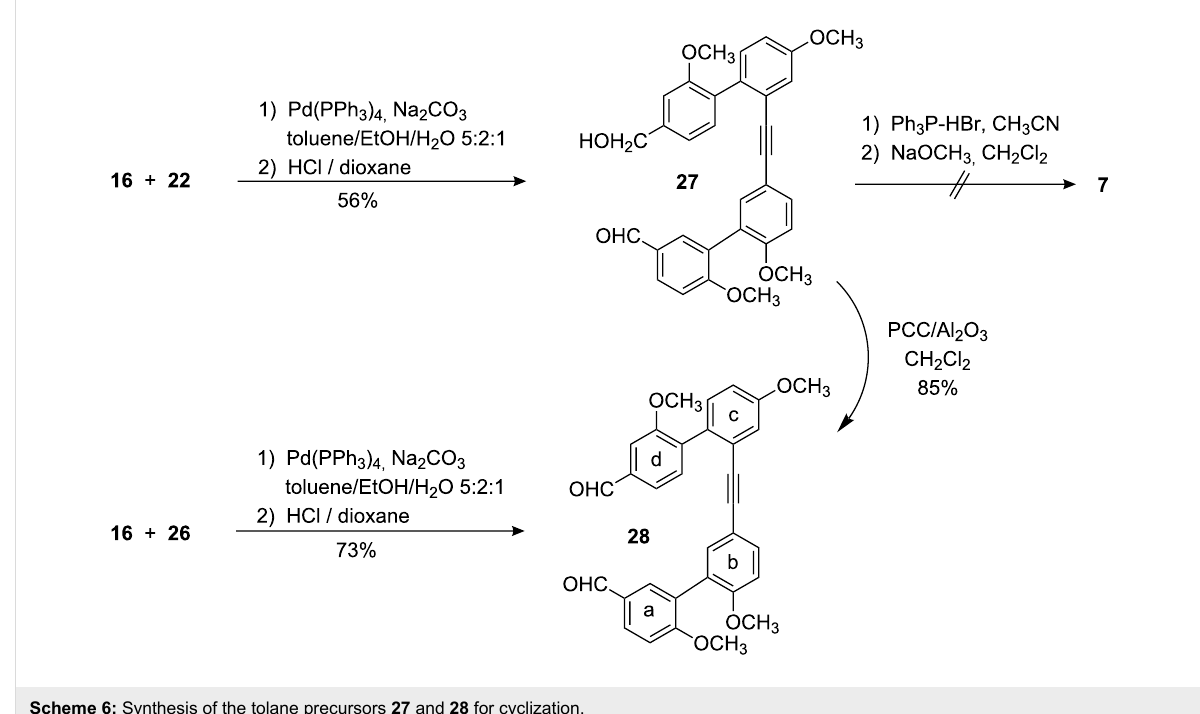
Scheme 6: Synthesis of the tolane precursors 27 and 28 for